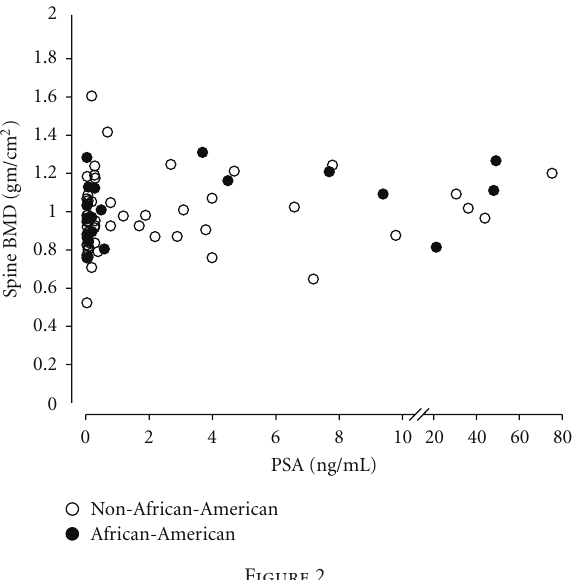
Non African-- African-American